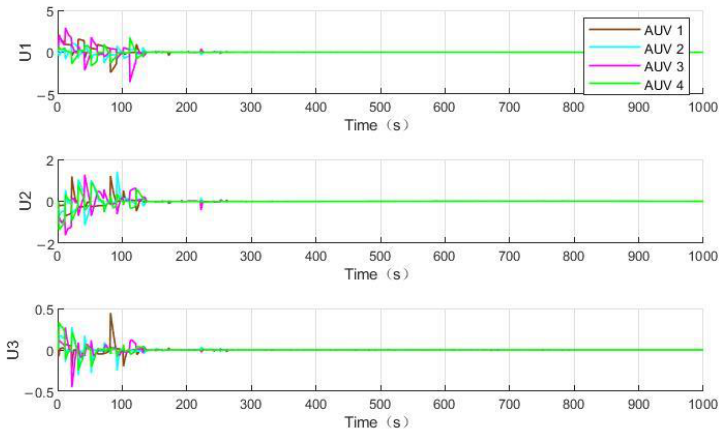
Figure 12. Control input of second-order integral model of followers.